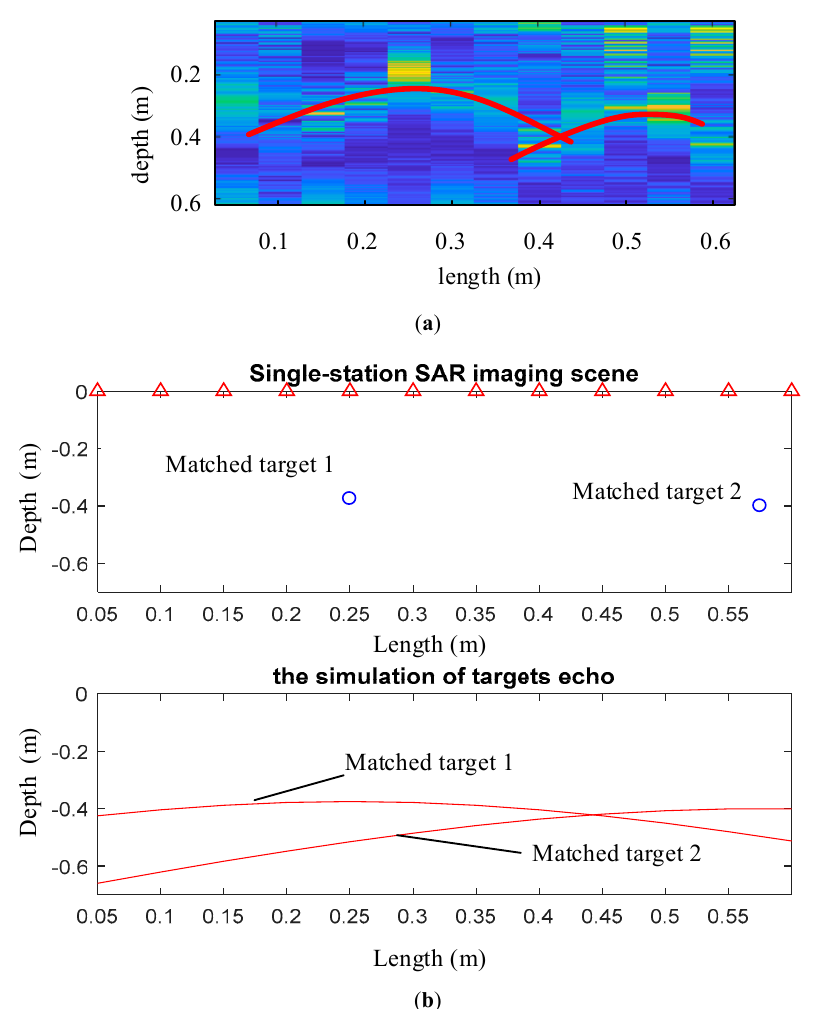
Figure 26. This picture shows the matching process described in step 2: ( a ) This section shows the characteristic echoes extracted from experiment results; ( b ) This section shows the matching result whose correlation coefficient r is 0.83. Table 5. Comparison between different antennas with the proposed